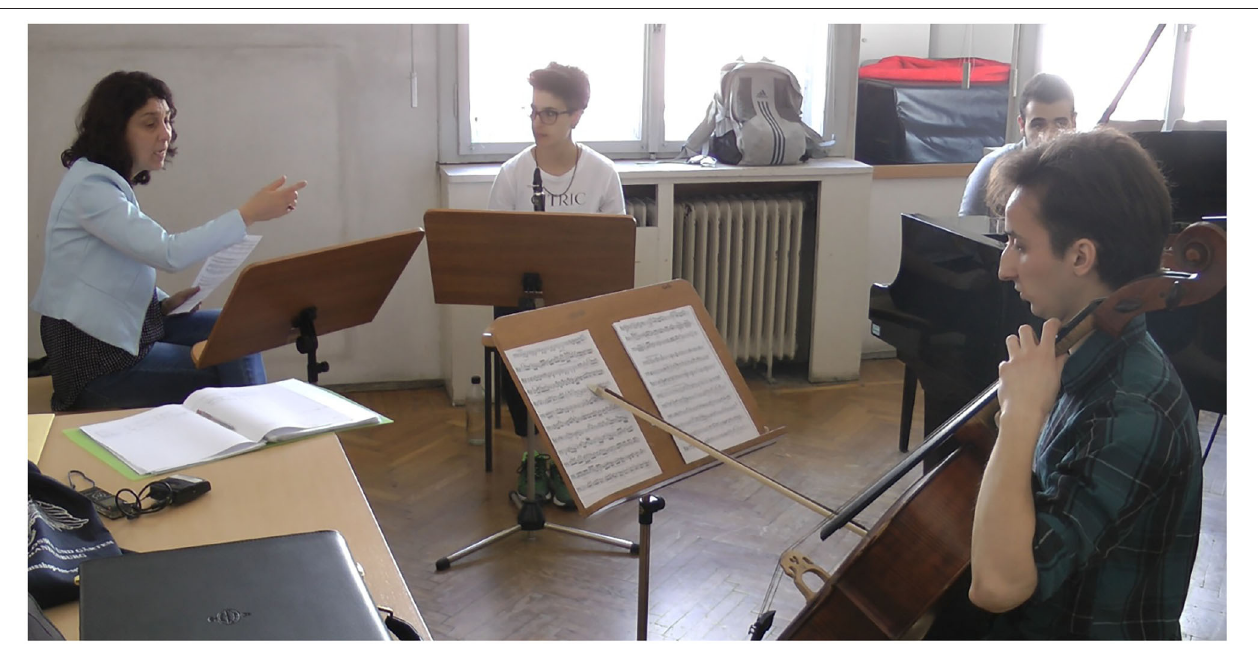
FIGURE 2 | Professor moves right hand on the